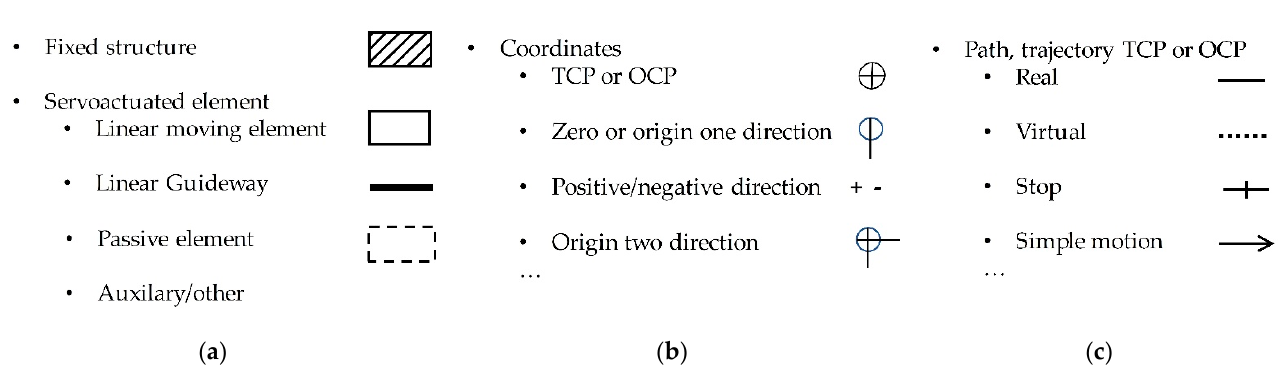
Figure 9. MMCS graphical symbology. ( a ) Mechanical symbols; ( b ) Motion symbols: coordinated system; ( c ) Motion symbols: trajectories.